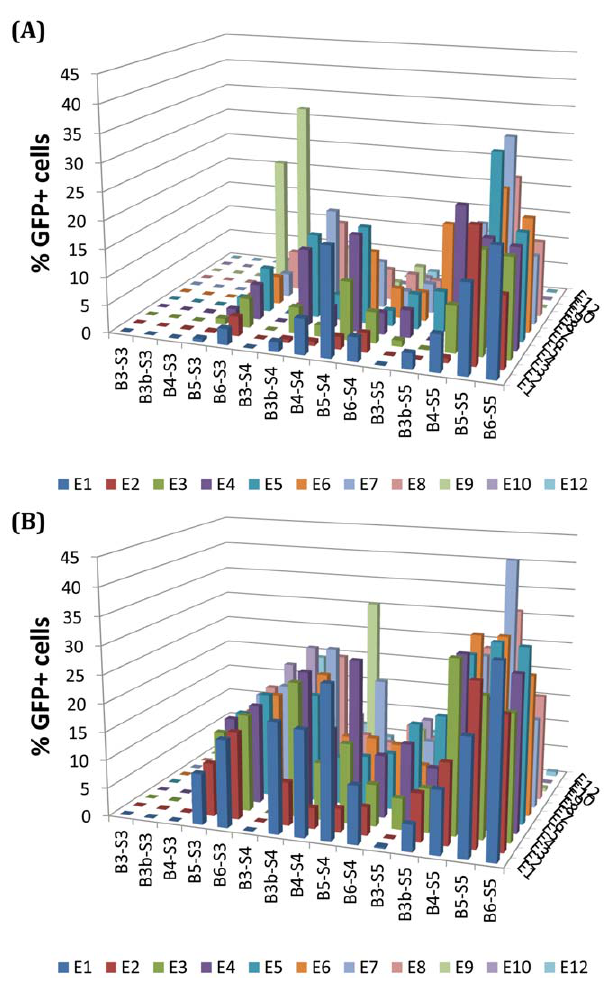
Figure 2. Bar graph displaying confluent ARPE-19 cell-sheet transfection efficacy (%GFP + cells by FACS) of polymer formulations (n=4) in our library screen. (A) Transfection efficacy of polymer library formulated at 30 w/w ratio. (B) Transfection efficacy of polymer library formulated at 60 w/w ratio. Optimal formulation B5- S5-E7 at 60 w/w resulted in 44% transfection efficacy as compared to 26% for Lipofectamine 2000, 22% for ExtremeGENE HP DNA, and 8% for branched 25 kDa PEI.